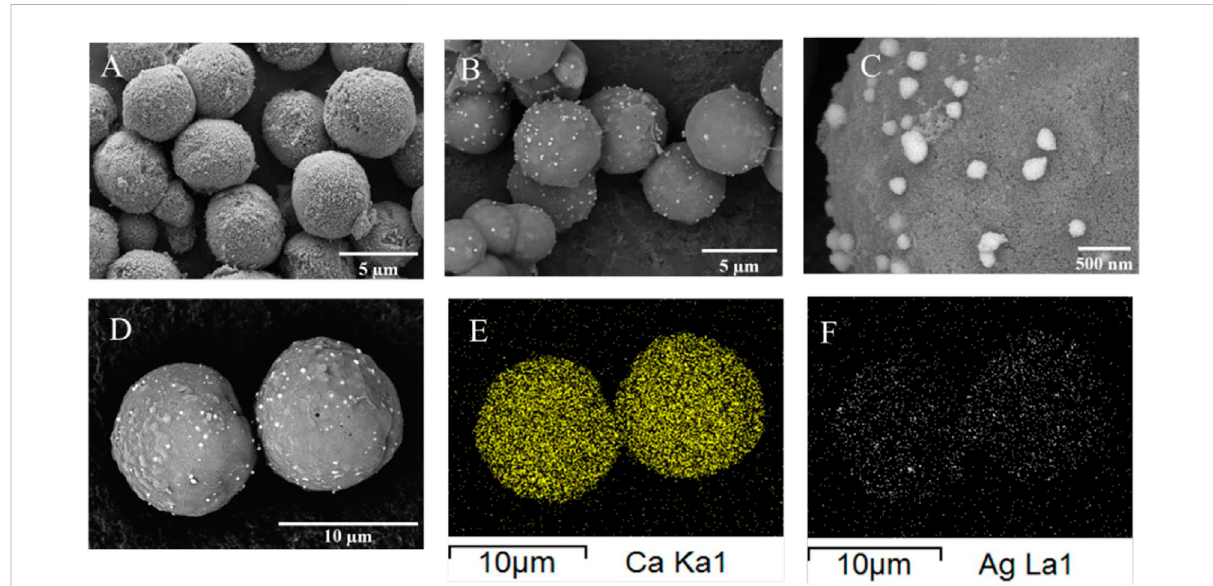
FIGURE 11 (A) SEM microimage of PCC particles without silver loading, (B) SEM microimage of PCC particles loaded with silver nanoparticles, (C) Higher magni fi cation of SEM microimage (B) , (D) SEM microimage of PCC loaded with silver nanoparticles. Reproduced from (Azarian and Sutapun,